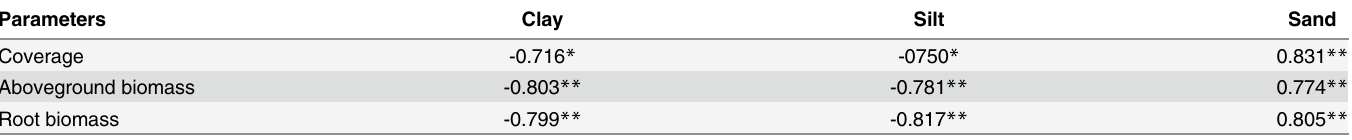
Table 4. Pearson correlation between soil PSD and plant